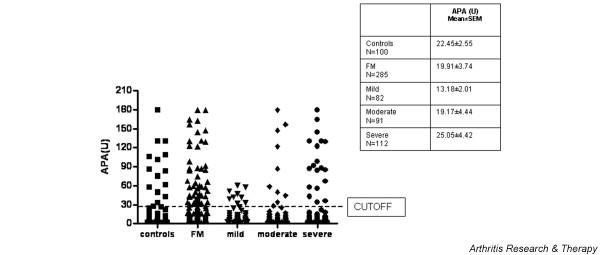
Antipolymer antibody levels in fibromyalgia patients and in control individuals. Antipolymer antibody (APA) levels in fibromyalgia (FM) patients (all patients and patients separated according to disease severity) and in control individuals. SEM, standard error of the mean.